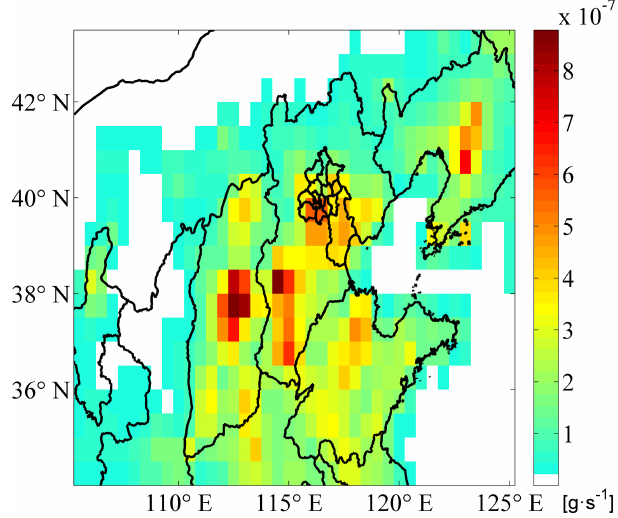
Figure 5. Gridded distribution of PM 2 . 5 primary emission sources.